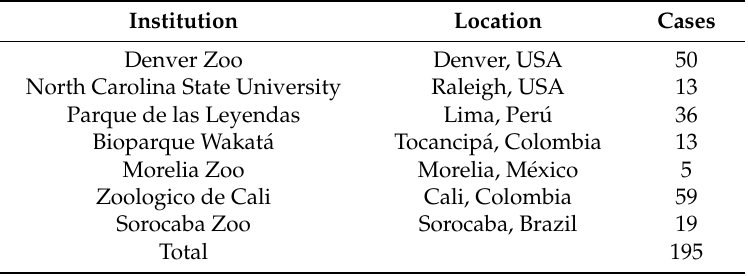
Table 1. Institutions and cases contributed to the survey of felid neoplasia.